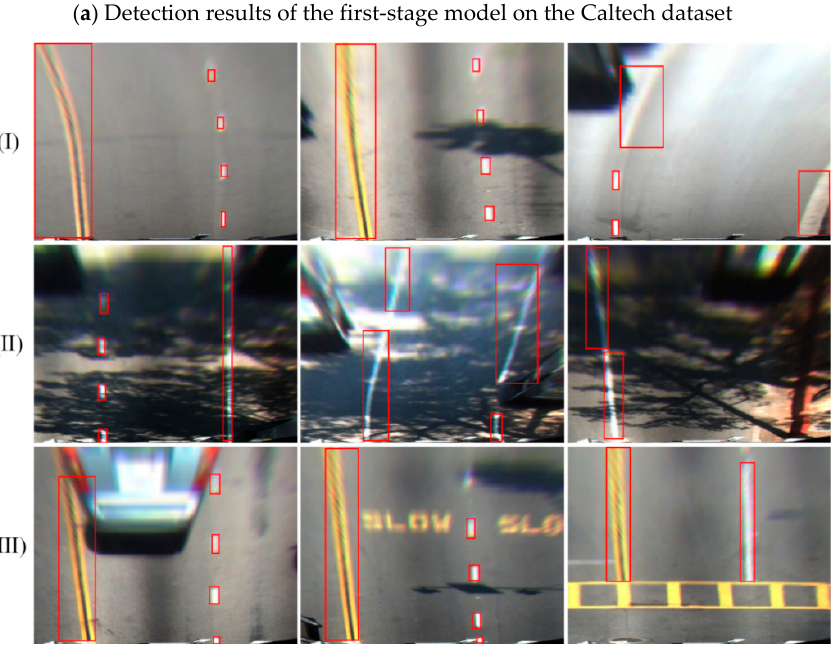
Figure 7. Lane detection results on the Caltech dataset.